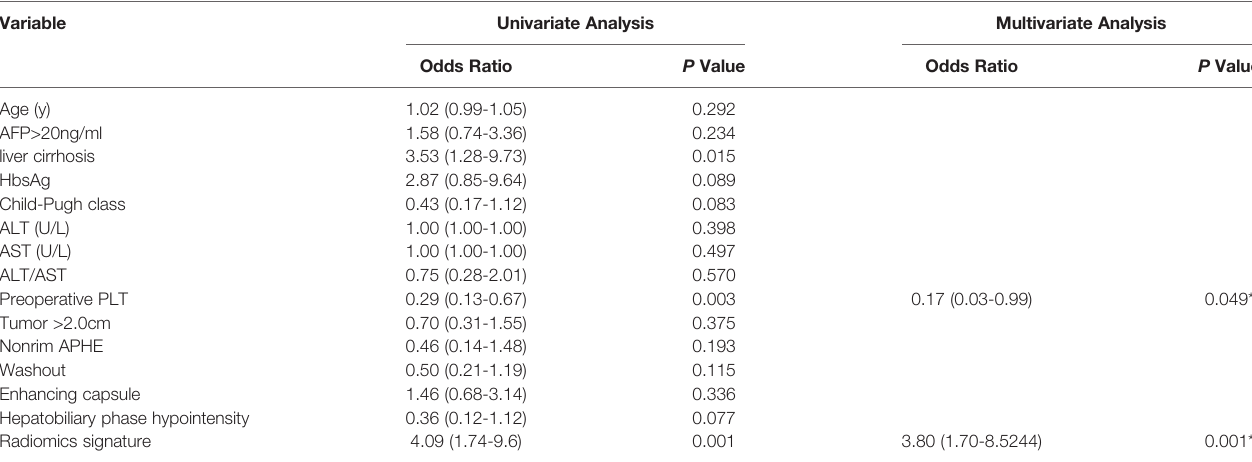
TABLE 3 | Univariate and multivariate logistic regression analyses of the risk factors for ER of HCC.